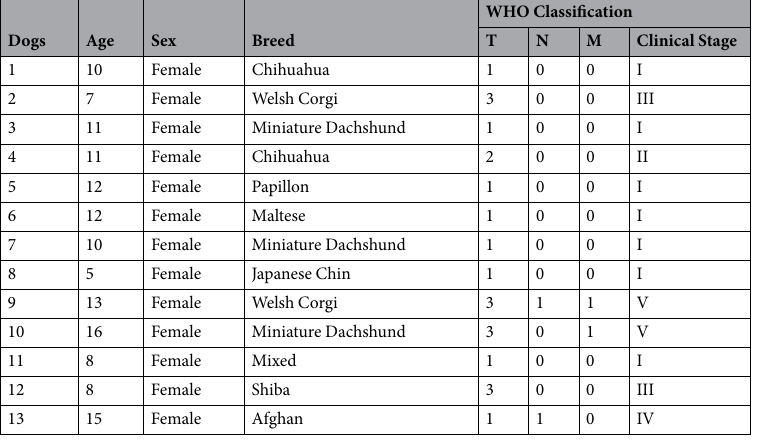
Table 1. Characteristics of dogs with breast